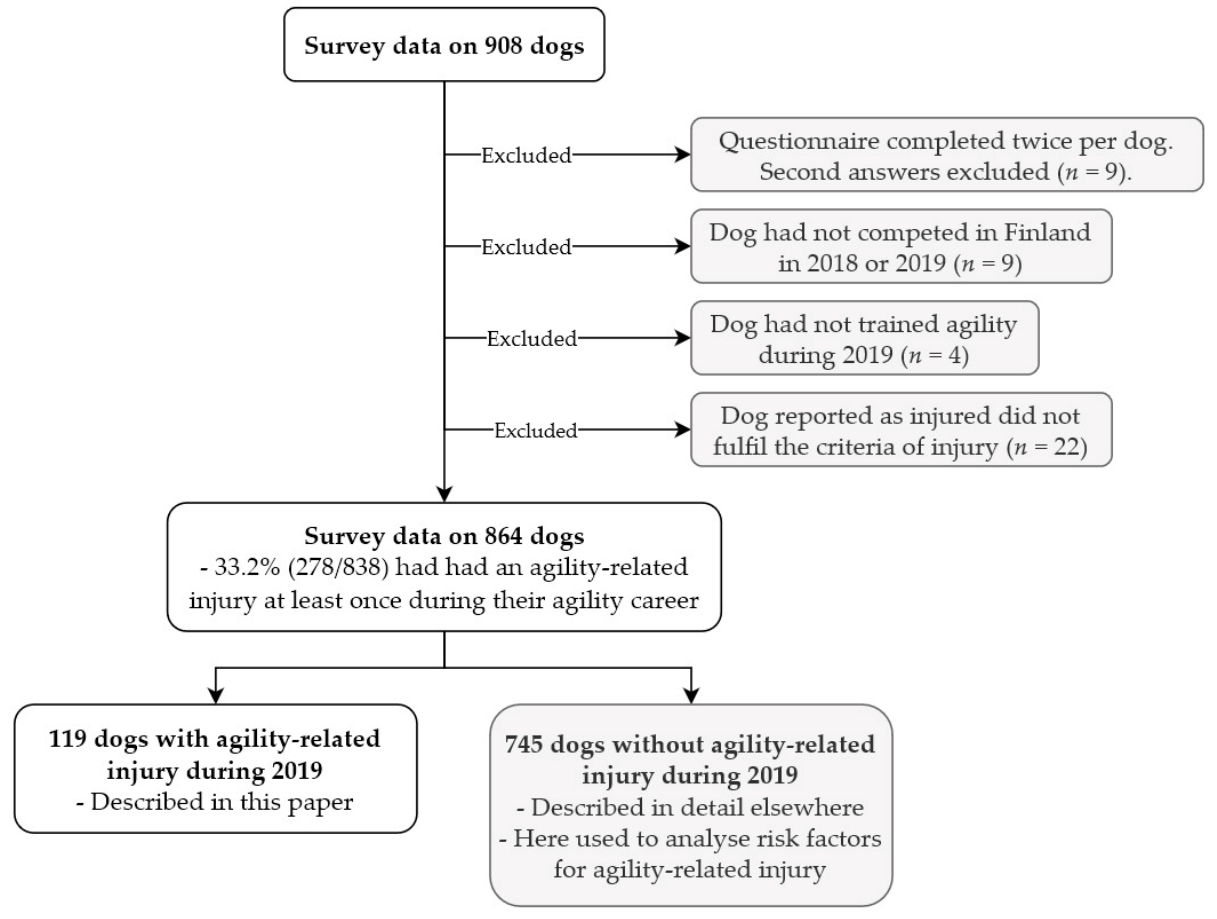
Figure 1. Dogs included in this